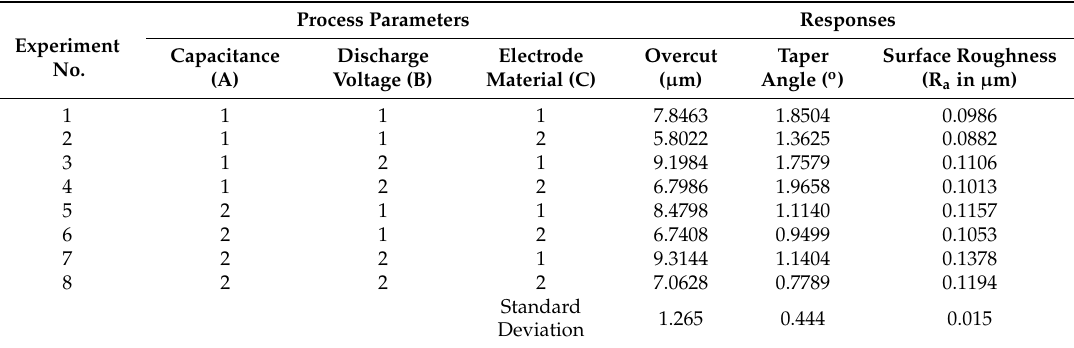
Table 4. Experiment scheme and